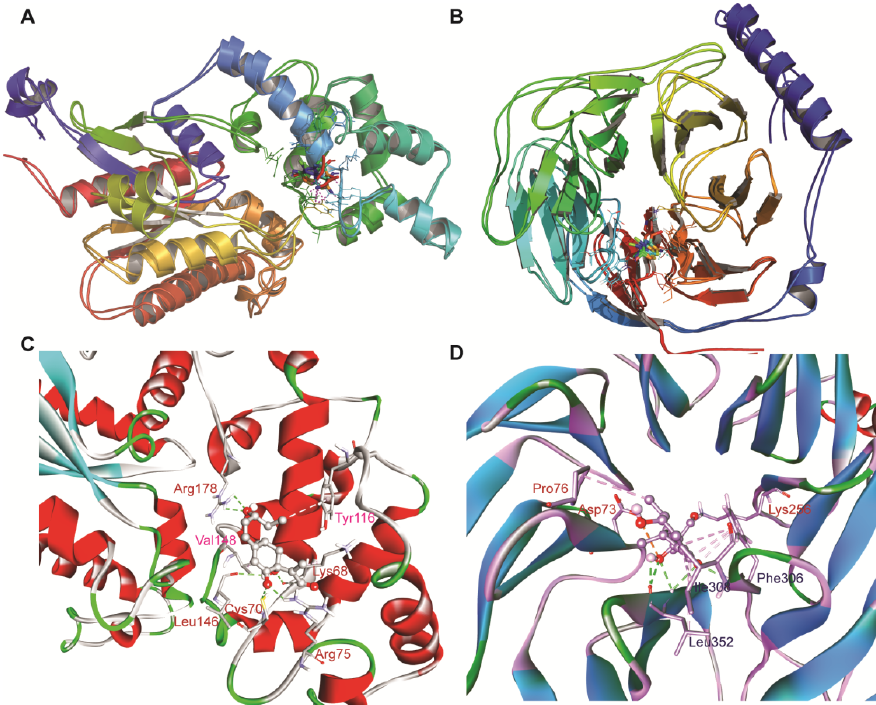
Figure 7. Structural superimposed view of the top two structural ensemble (top-ranked two clusters obtained from clustering). ( A ) Superimposed architecture of top-ranked two clusters from G-alpha subunit complex. ( B ) Superimposed architecture of top-ranked two clusters from G-beta subunit complex. Both the images were rendered using PyMOL. ( C ) Intermolecular contact of top-ranked cluster of Bipolaroxin with G α subunit where the H-bond forming residues are marked in red while other nonbonded contacts are in pink. ( D ) Protein–ligand interaction analysis of the top-ranked cluster of Bipolaroxin with G β subunit where the H-bond forming residues are marked in blue while other nonbonded contacts are in red. The image was generated using BIOVIA DSV.